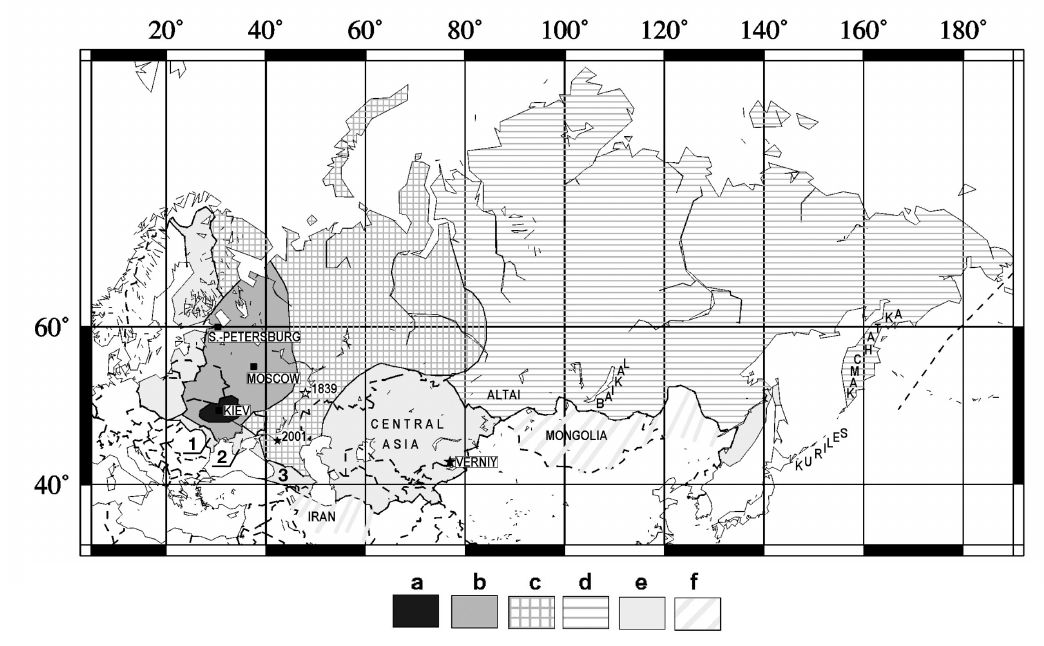
Fig. 1. Territorial expansion of the Russian state: a – the first Russian state formed in the 9th century (Kiev Russia); b – independent Russian princedoms established in the next 300 years (Moscow princedom was founded in 1147); c – Russia after forming the centralised state (beginning of the 17th century); d – territories included in Russia in 17th century (up to 1689); e – Russia before the World War I; f – regions under strong influence of Russia at the beginning 20th century. Dates of two events discussed in this paper are shown: 1839 – a falsequake from Volga River basin; 2001 – a moderate magnitude event on the southern part of Russian platform. Verniy (modern Alma-Ata) is indicated in re- lation with the earthquake of 1887 presented as example of preinstrumental stage of earthquake studies in Russia. Numbers on map stand for: 1 – Eastern Carpathia; 2 – Crimea; 3 – Eastern Anatolia and